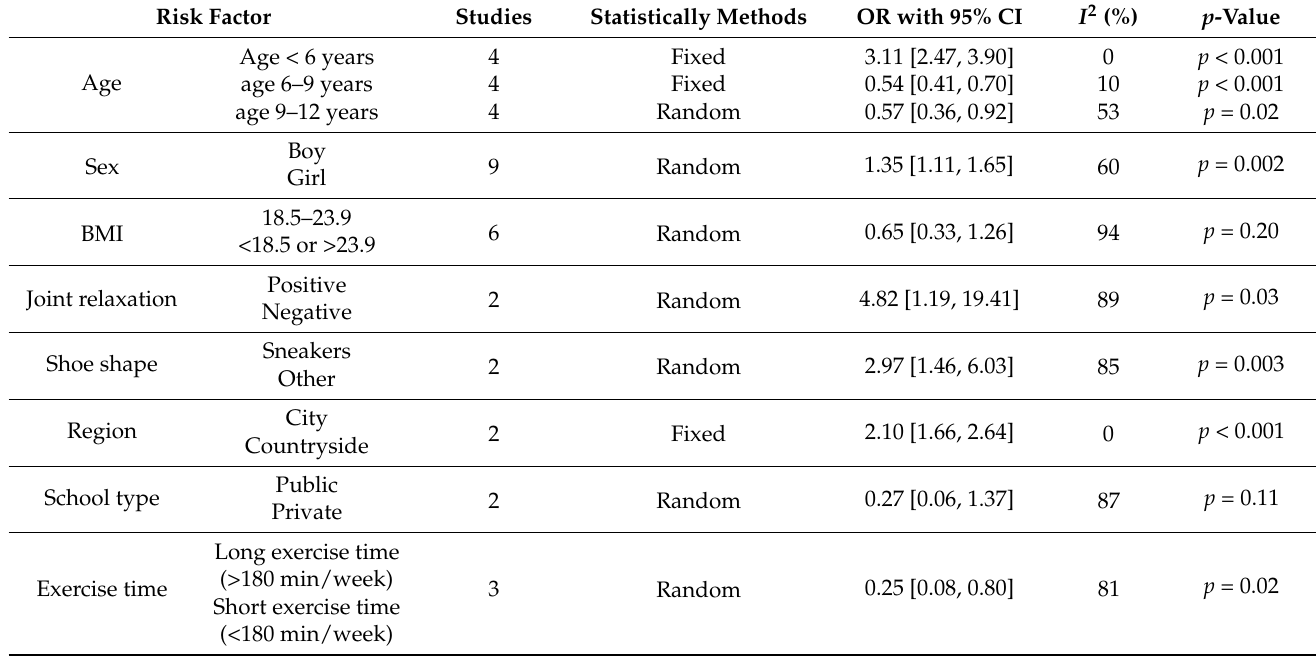
Table 2. Meta-analysis of risk factors for flatfoot in children.